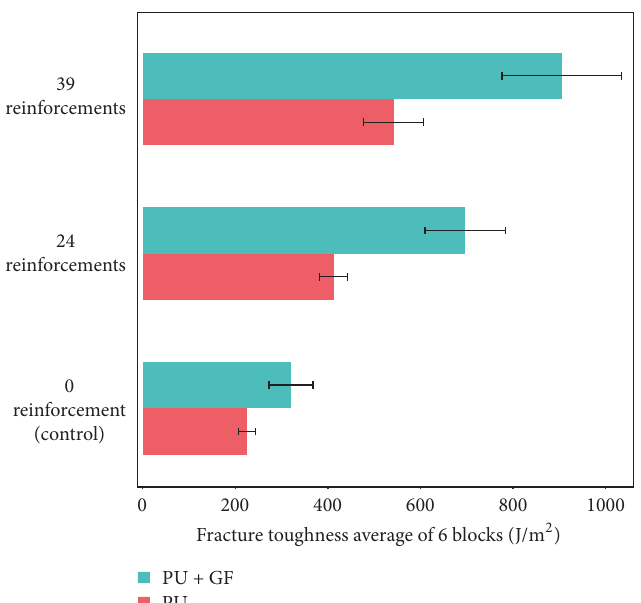
Figure 3: Fracture toughness values of specimens containing through-reinforcement and glass-fibre in adhesive bond lines versus fracture toughness of the